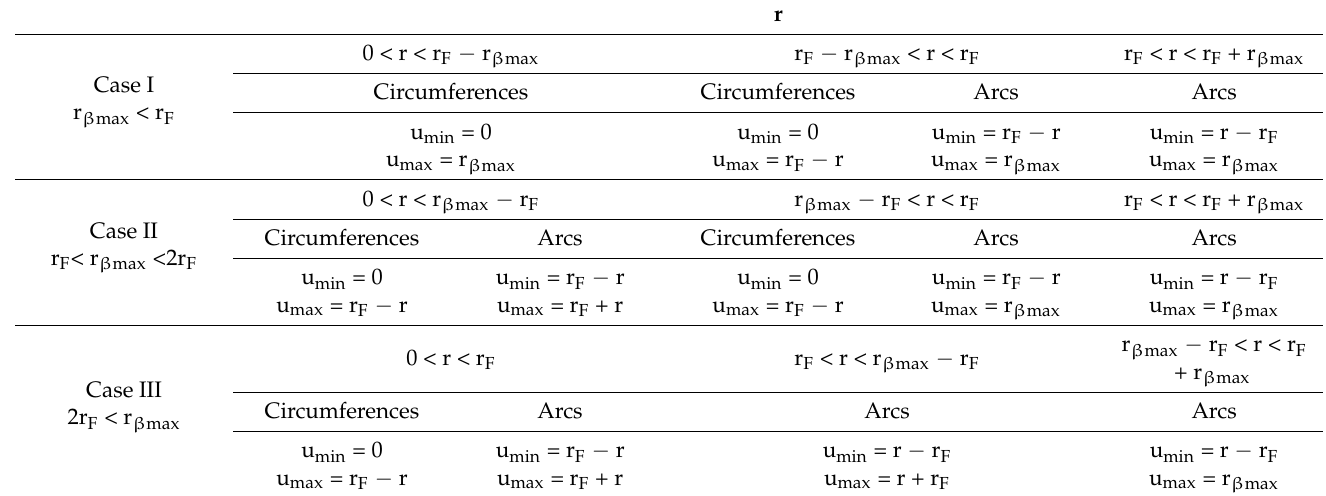
Table 1. Integration limits of u according to the ratio between r β max and r F for different values of r .